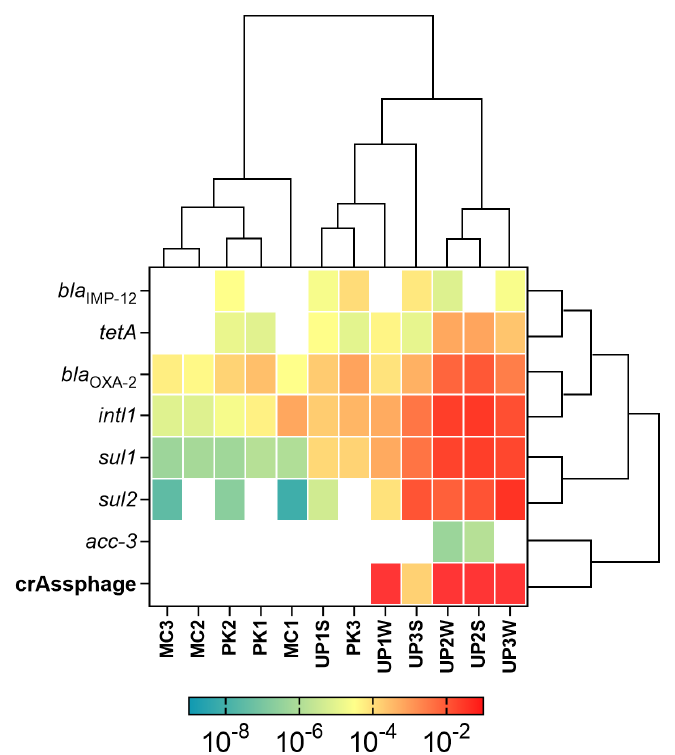
Figure 4. Normalized abundance of ARGs, intl1 , and crAssphage detected on sediments and water. The abundance values of ARGs and intl1 were normalized to 16S rRNA gene abundance, and the absolute abundance of crAssphage was included. The data were transformed using Log (10) and represented in a heatmap where reddish coloration symbolizes a higher abundance. Rows and columns were ordered by similarity with hierarchical clustering. S: Sediments; W: Water.